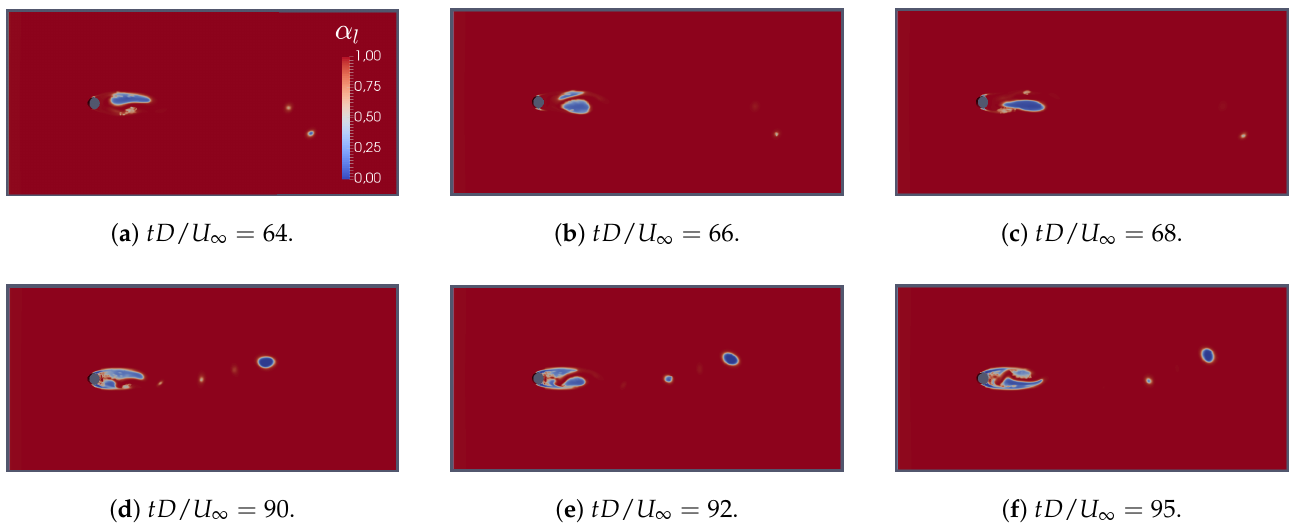
Figure 16. Contour plot of instantaneous liquid fraction, results obtained with Saito model and considering analytical-based coefficients (Table 3).